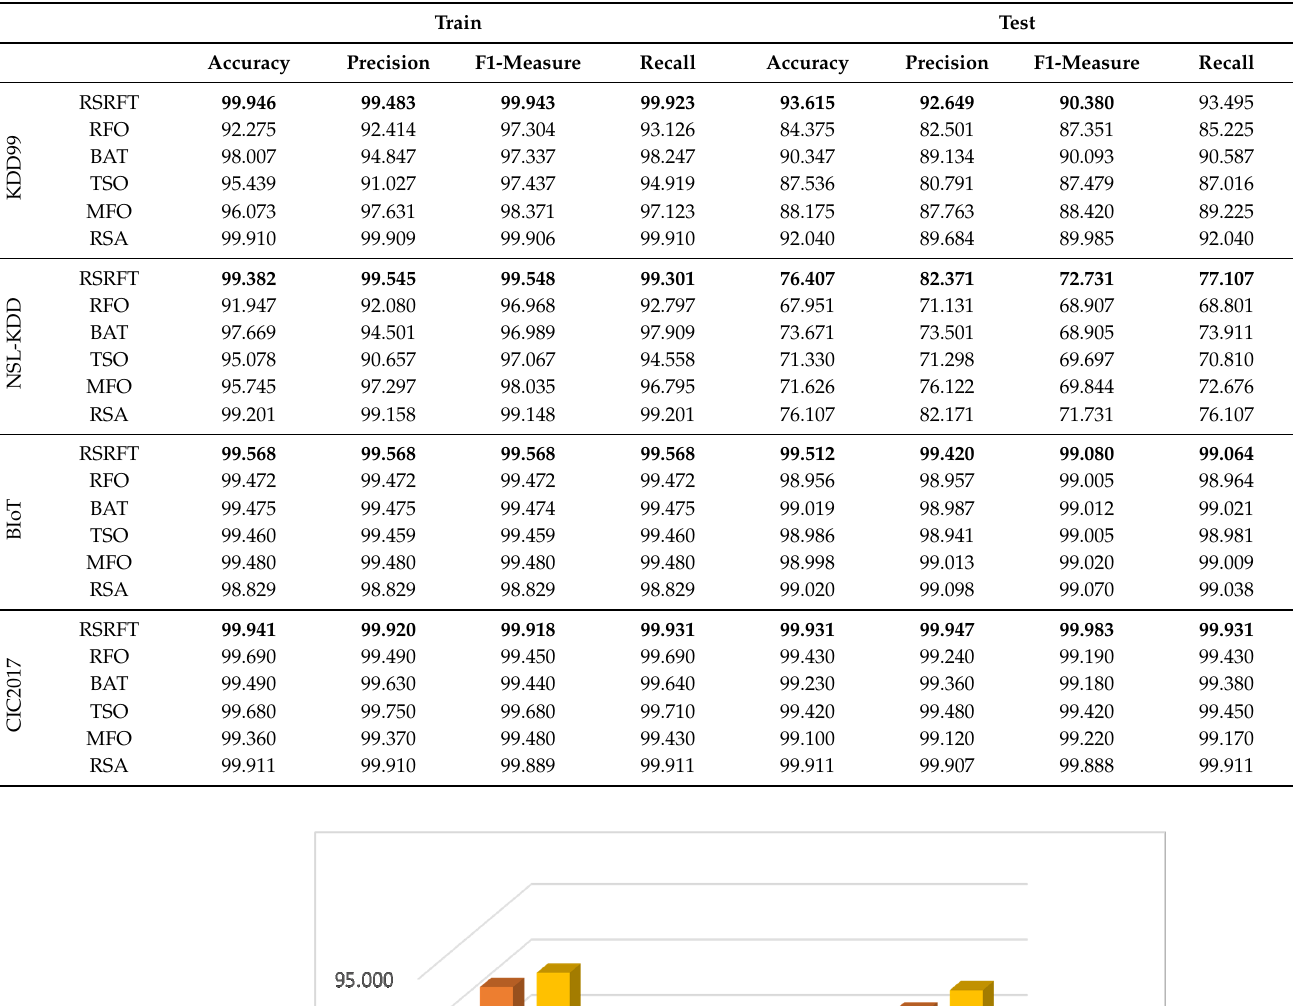
Table 8. Results of RSRFT for improving the detection of IDSs in the IoT environment.